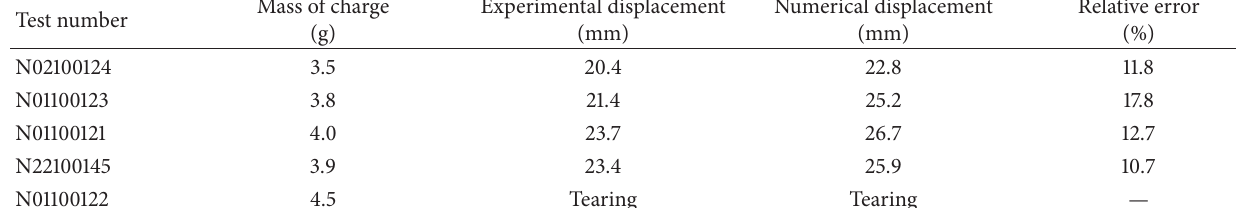
Table 6: Experimental and numerical results for selected cases.